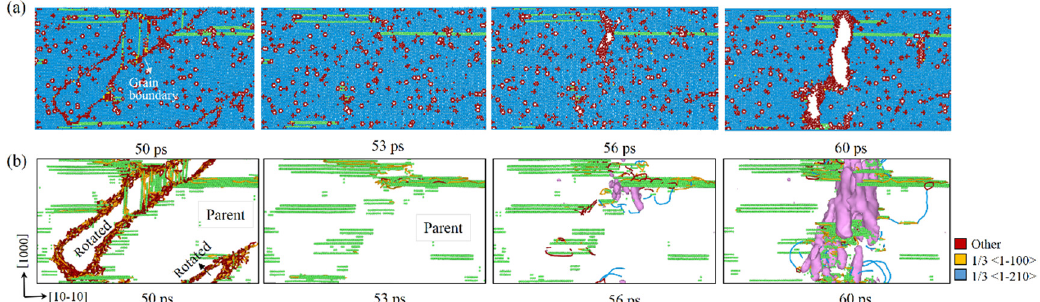
Figure 8. ( a ) Atomic configurations in the A region of the sample with C v = 1.0% loading along the [10 – 10] direction. ( b ) Schematic illustration of the reorientation mechanism from parent HCP (PHCP) structure to rotated HCP (RHCP) structure via atomic shuffling and rearrangement. The possible route of the atomic rearrangement is indicated by the arrow, with atoms of each color representing the same direction of motion.